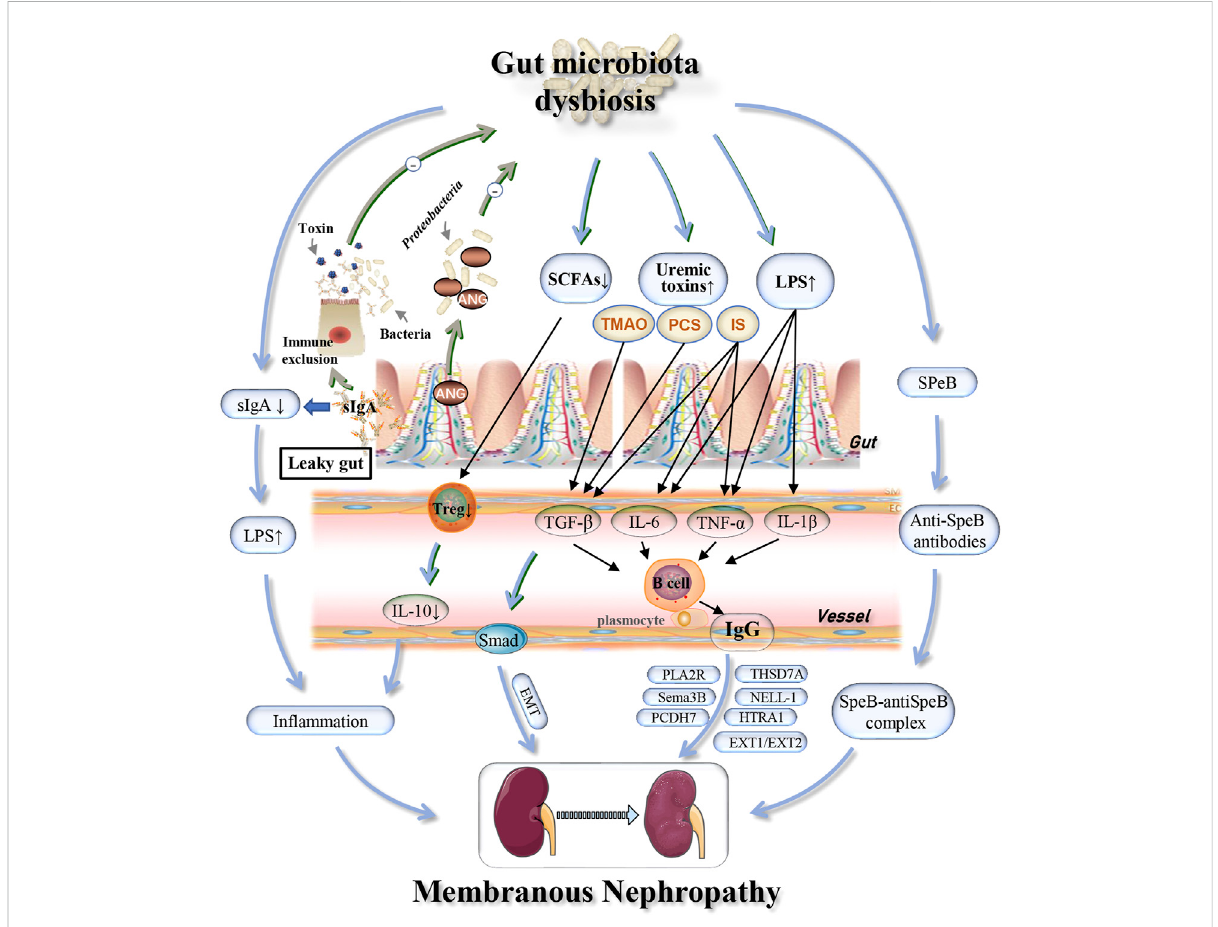
FIGURE 4 Possible mechanisms associated with gut dysbiosis and effects of host immunity on gut microbiota in IMN patients. Alterations in the speci fi c microbiome may be involved in thepathogenesis and developmentof IMN throughdepletion of SCFAs and sIgA, increased cytokines (TNF- α , IL-1 β ), uremic toxins (PCS, IS, TMAO), and common antigens (SPeB) with the glomerular basement membrane. The host immune system can regulate the gut microbiota homeostasis through the production of sIgA and the induction of Ang. IMN, idiopathic membranous nephropathy; sIgA, secretoryimmunoglobulinA;TMAO, trimethylamineN-oxide;PCS,p-cresolsulfate;IS,indoxyl sulfate;IL,interleukin; TNF- α ,tumornecrosisfactor- α ;TGF- β ,transforminggrowth factor- β ;Treg,regulatoryTcells;EMT,epithelial-mesenchymaltransition;SPeB,streptococcalpyrogenicexotoxinB; PLA2R, phospholipase A2 receptor; THSD7A, thrombospondin type 1 domain-containing 7A; EXT1/EXT2, exostosin 1/exostosin 2; NELL-1, neural